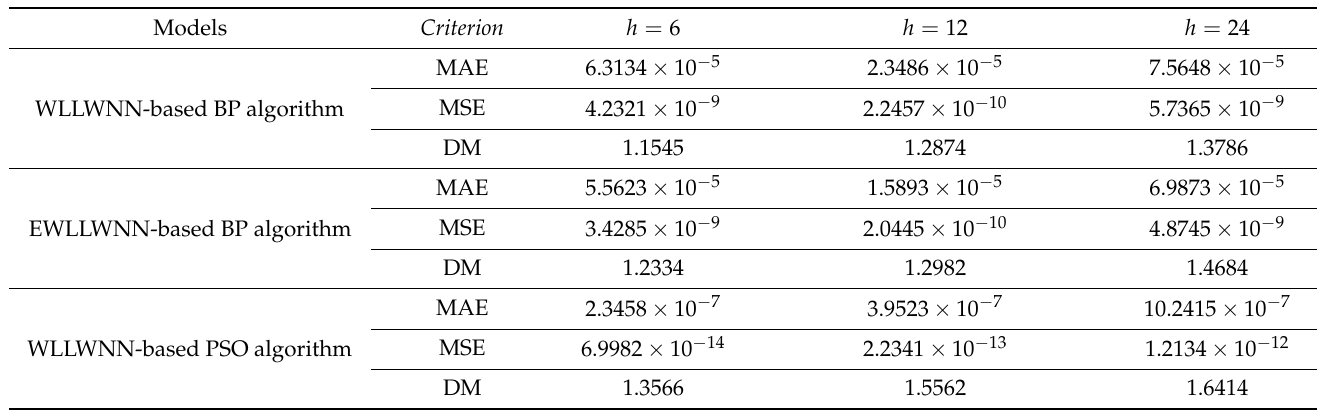
Table 6. Out of sample forecasts